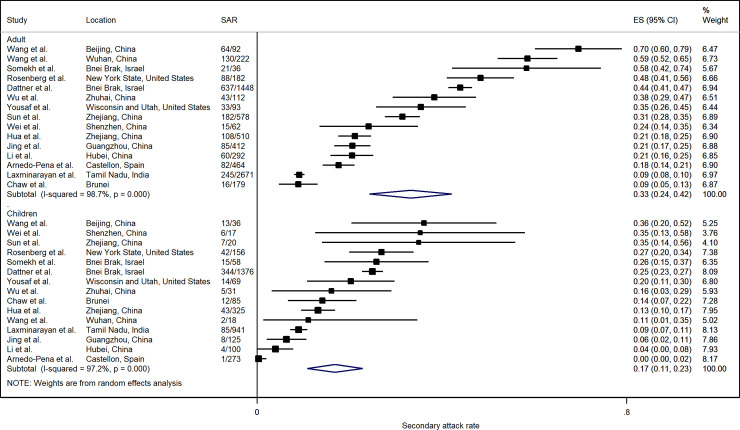
Forest plot of household secondary attack rates (SAR) by adult and children close contact.ES is the estimated SAR, with 95% confidence intervals (CI). I-squared is the percentage of between-study heterogeneity that is attributable to variability in the true effect, rather than sampling variation.